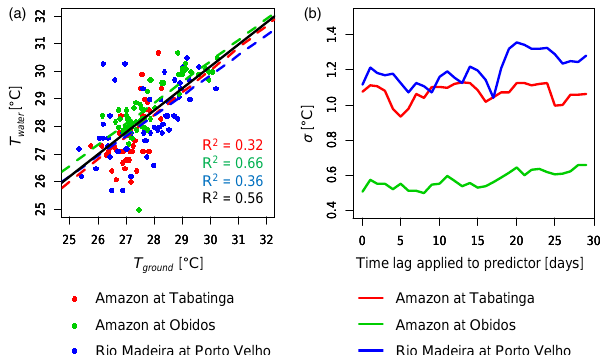
Figure 7. Predictability of water temperature ( T water ) from sim- ulated ground temperature ( T ground ). (a) Linear regressions be- tween T water and T ground recorded on the same day. The black line represents the linear fit through all data combined, while the coloured dashed lines represent the linear fits per sampling location. (b) Changes in RMSE ( σ ) of the prediction equation per sampling location after applying different time lags to the predictor, T ground